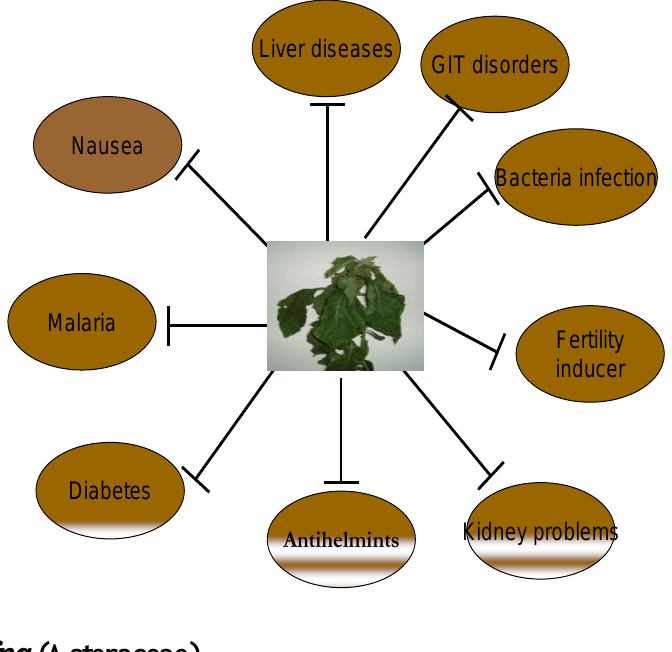
Figure 1. Traditional uses of Vernonia amygdalina (Bitter